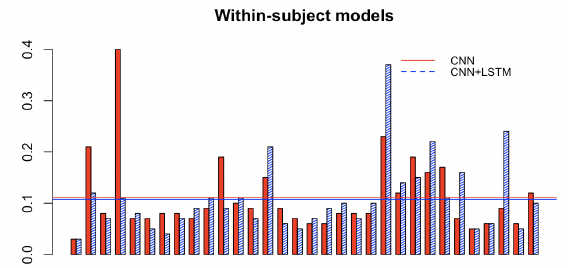
Figure 8. Paired histogram of the Mean Absolute Percentage Errors (MAPE) of the test data of the 32 within-subject models, respectively, trained only with the single Convolutional Neural Network (CNN), and the Convolutional/Recurrent Neural network